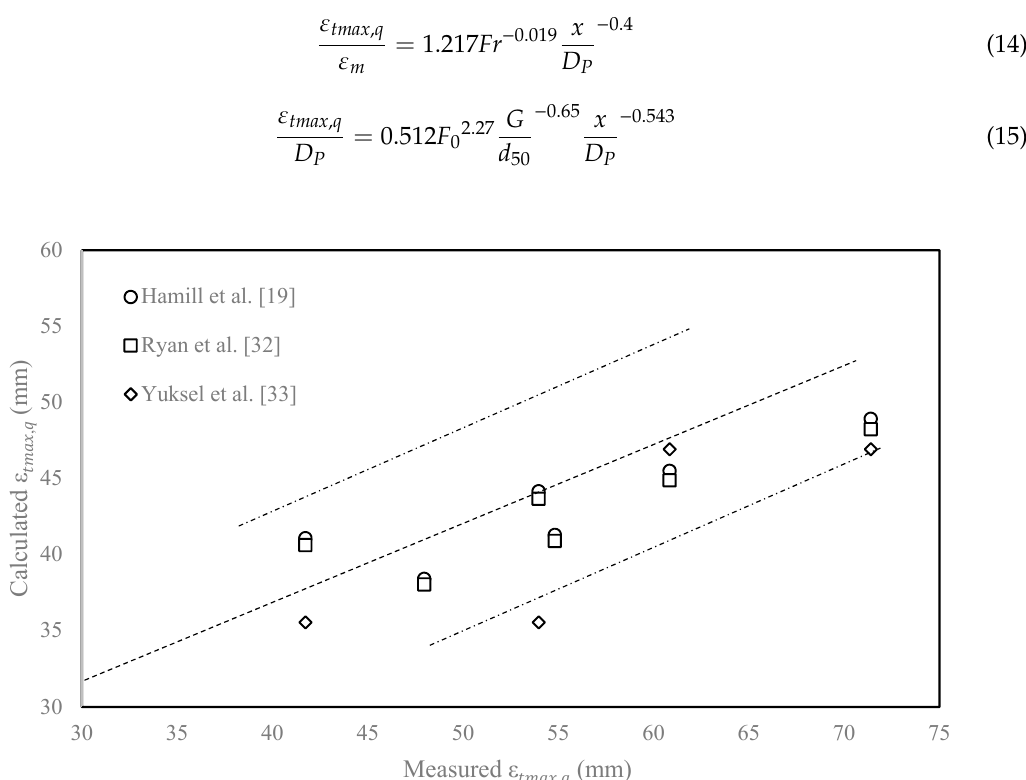
Figure 9. Comparison between the calculated results and the experimental results